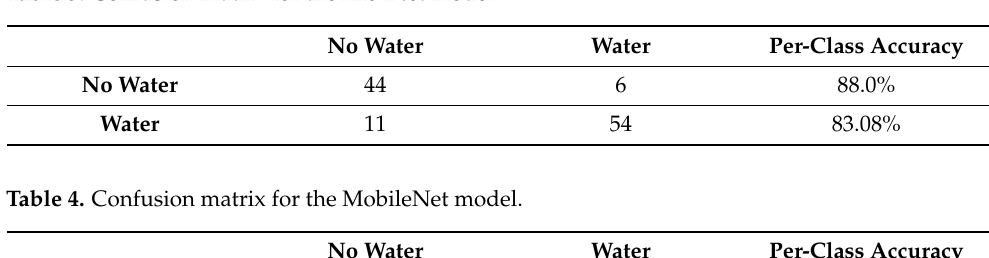
Table 3. Confusion matrix for the AlexNet model.